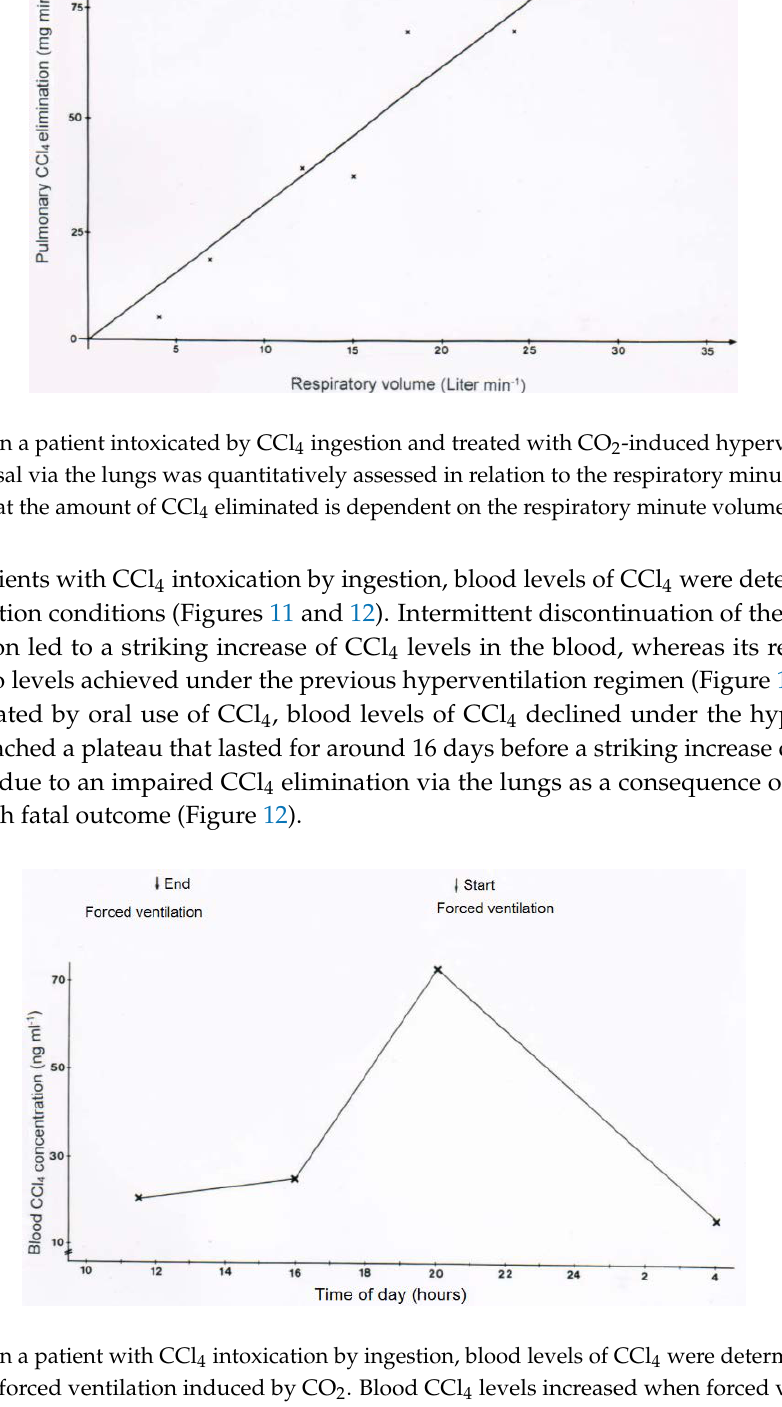
Figure 11. In a patient with CCl 4 intoxication by ingestion, blood levels of CCl 4 were determined with or without forced ventilation induced by CO 2 . Blood CCl 4 levels increased when forced ventilation was terminated and decreased again with reinstitution of forced ventilation.